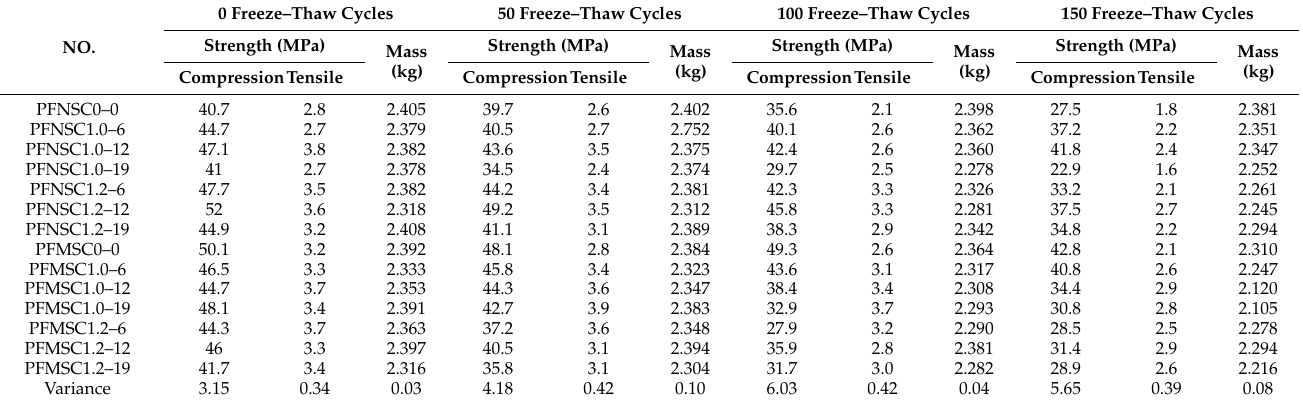
Table 3. Compressive strength, split tensile strength, and quality under different freeze–thaw